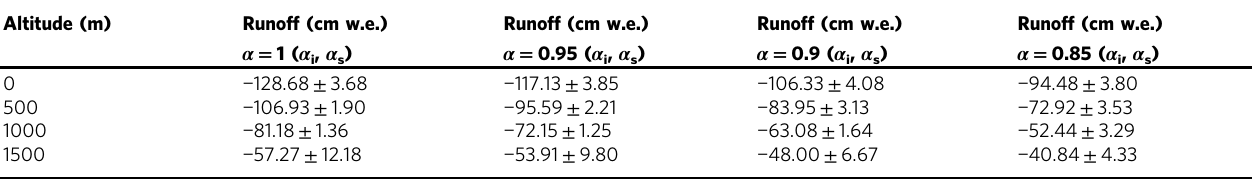
Table 1 Modeled change in runoff in response to a summer high-latitude eruption Altitude (m) Runoff (cm w.e.) Runoff (cm w.e.)